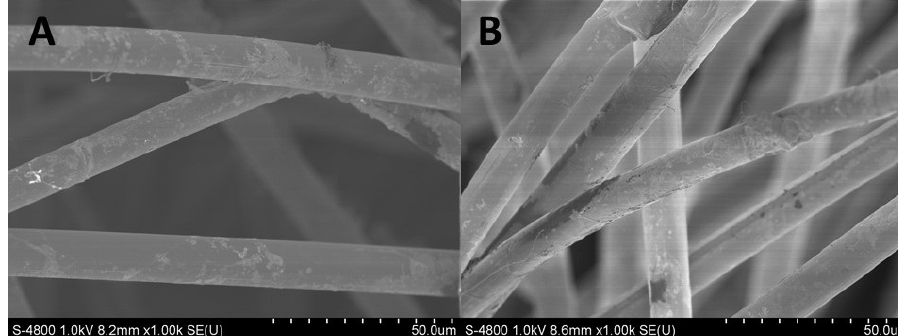
Figure 9: SEM images of GO-AFs ultrasounded with different time: (A) 10 min. (C) 30